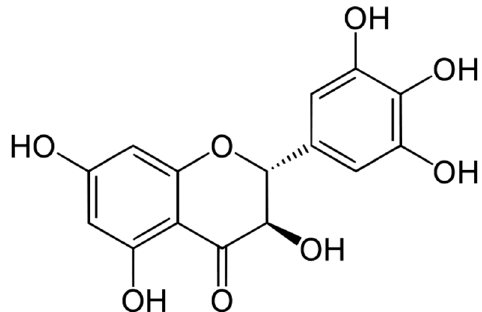
Figure 1. The chemical structure of dihydromyricetin (DHM): an active flavonoid [(2 R ,3 R )-3,5,7- trihydroxy-2-(3,4,5-trihydroxyphenyl)-2,3-dihydrochromen-4-one, PubChem CID: 161557] found in abundance within Ampelopsis grossedentata